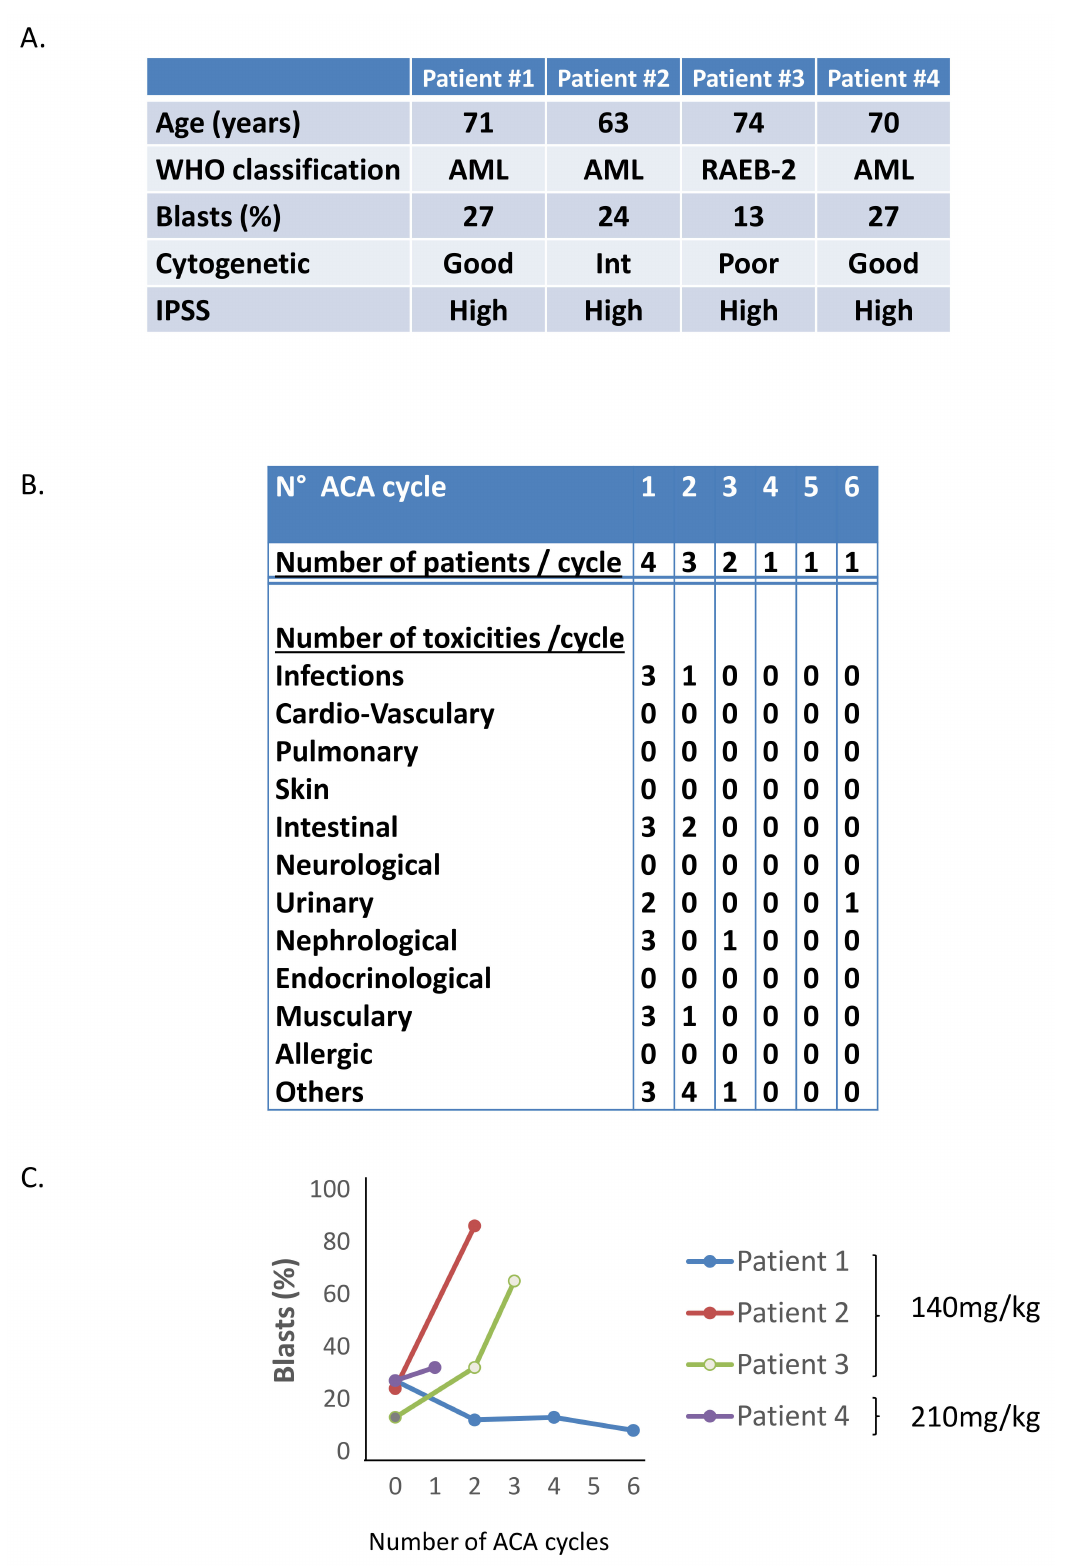
Figure 4. Phase I / II clinical trial of Aca in Aza-refractory MDS / AML patients. Four patients (1 MDS, and 3 AML) were enrolled in the assay and treated on Day 1 (D1), D3, D5, D8, D10 and D12 of a 28–56 day-course with Aca at 140 and 210 mg / kg. ( A ) Characteristics of the four enrolled patients. ( B ) Main side e ff ects of the 4 enrolled patients. ( C ) Blast counts of the di ff erent patients during the course of